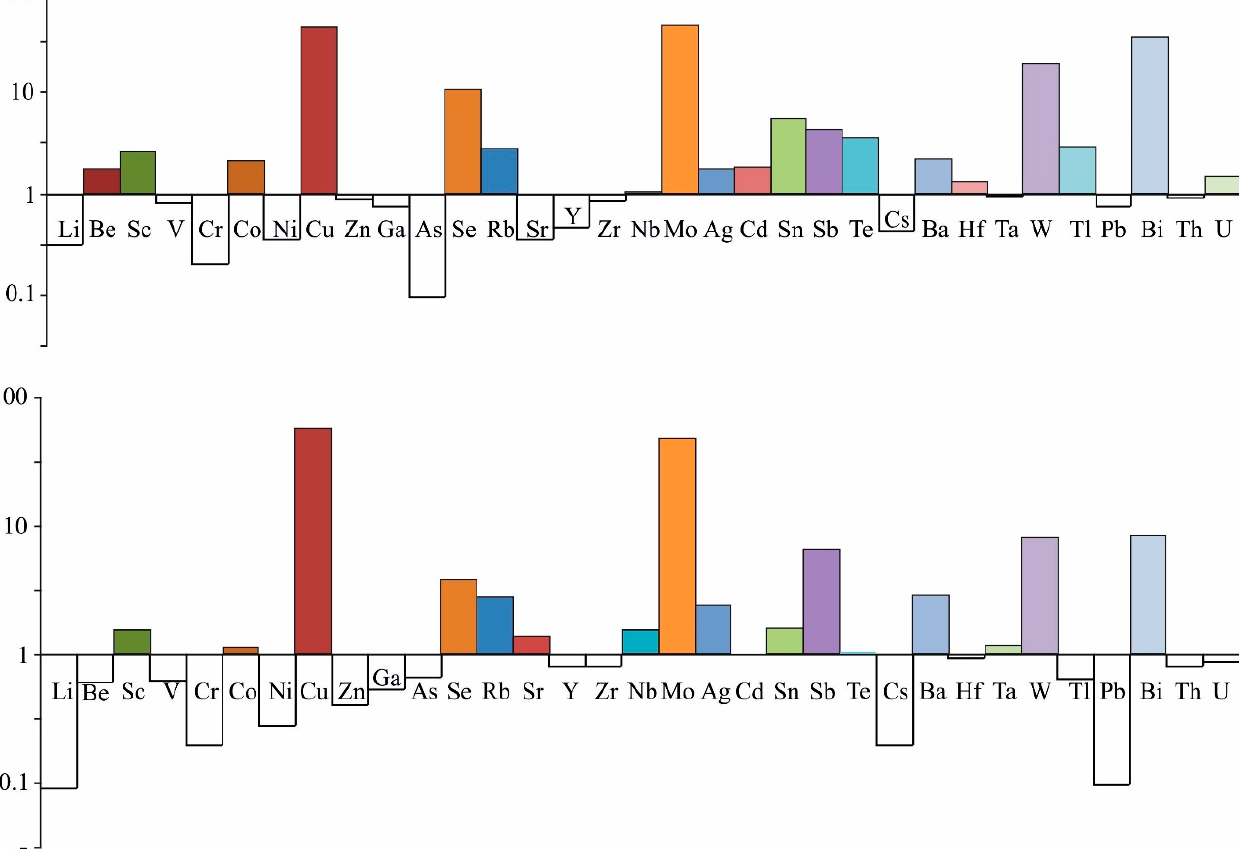
Figure 7. Trace elements spectra in the muscovite–kyanite schist (KV-112 and PDD-1) in the mineralized stockwork compared to the slightly altered granite porphyry (AK-721).